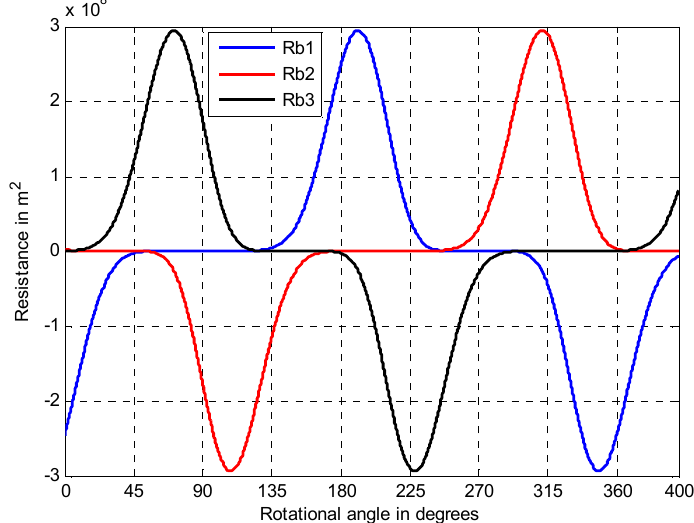
Figure 14. Variations of the blade total resistance as a function of the rotational angle. Energies 2016 , 9 , 820